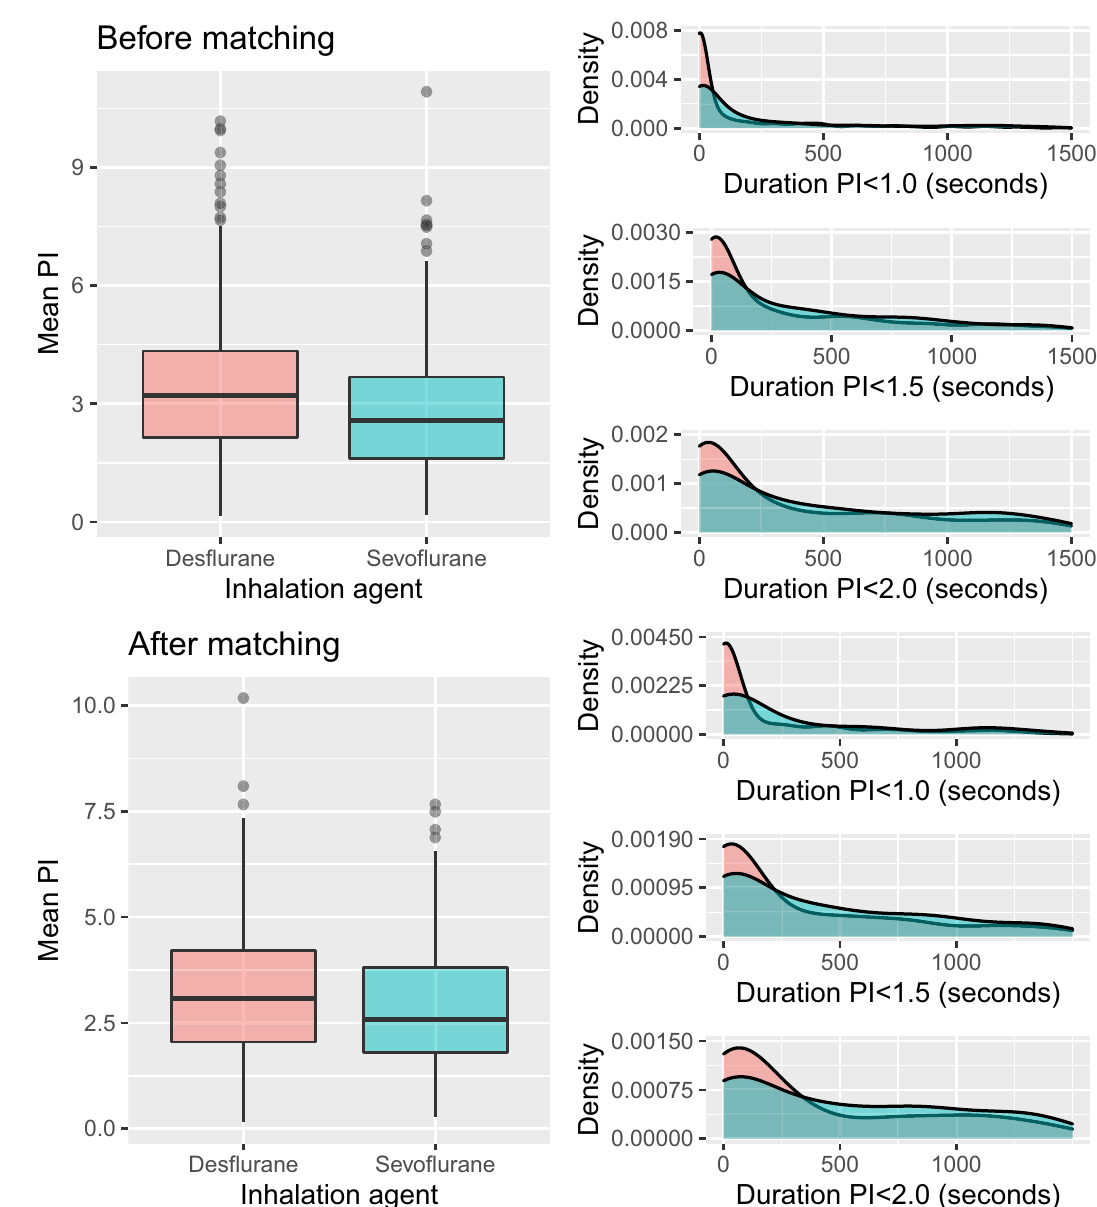
Figure 2. Box-and-whisker plot of mean perfusion index (PI) and kernel density plots of the duration of PIs below threshold stratified by the type of inhalation agent before (upper) and after (lower) the propensity score matching. Kernel density estimation is a non-parametric method of estimating the probability density function of a continuous random variable. The probability density function is used to specify the probability of the random variable falling within a particular range of the variable and the area under the entire curve is equal to one. Based on the presented kernel density plots, shorter durations of low PI values in patients administered desflurane than sevoflurane can be